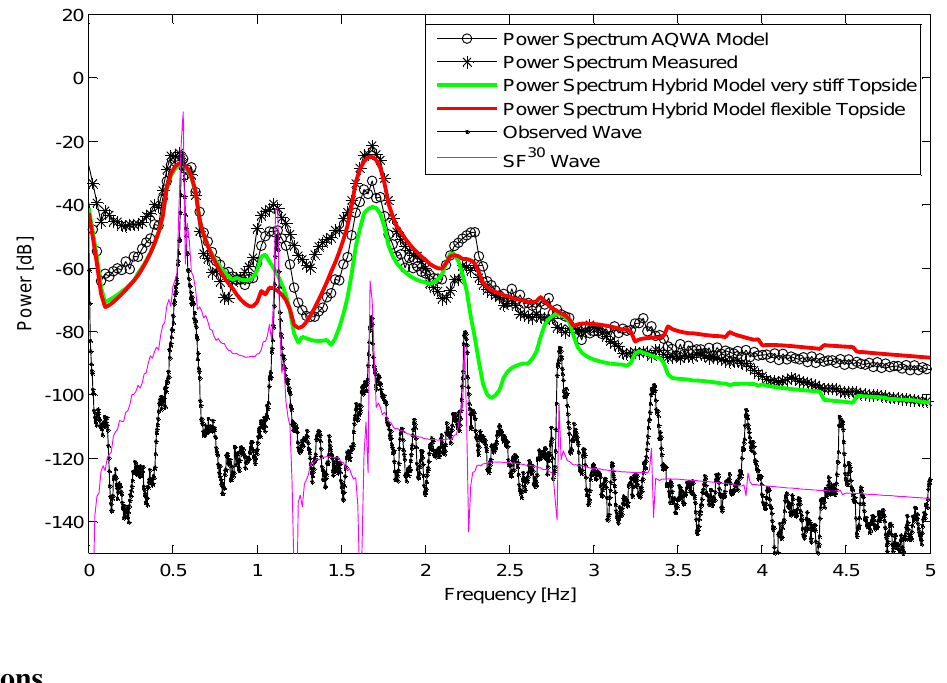
Figure 14. Code-to-code and code-to-experiment power spectral density comparison of the pitch motion response for the quasi-rigid, stiff and flexible hybrid model under regular wave load